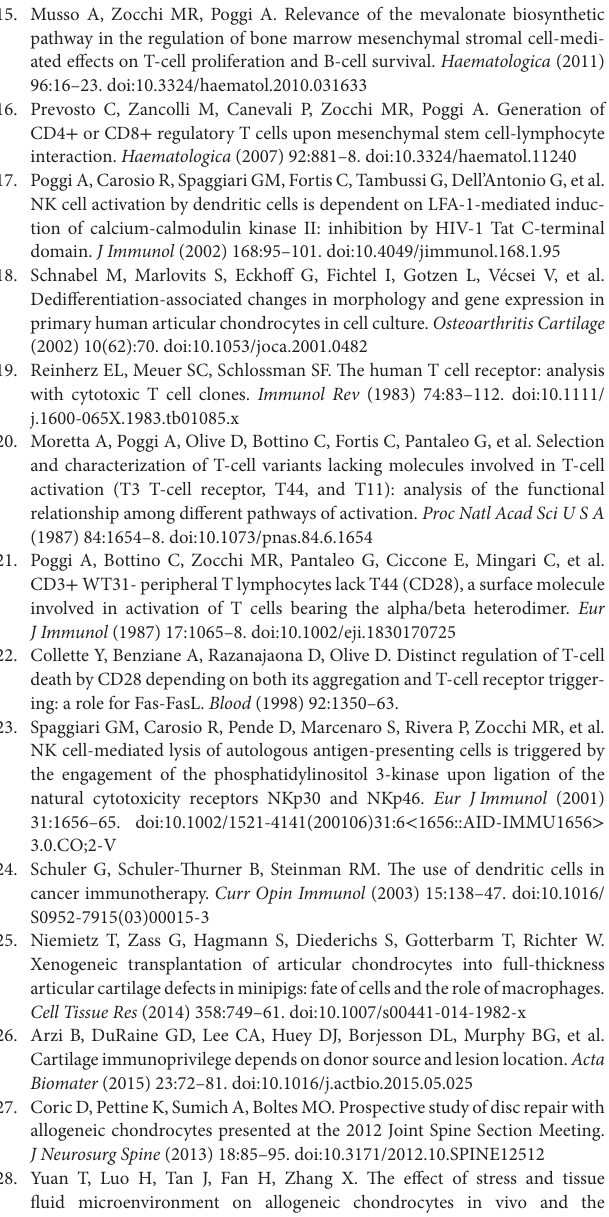
CD1a; lower left double-negative cells; lower right single CD1a + cells) on the basis of negative controls stained with an unrelated mAb matched for the isotype. Optimal compensation between the various color was performed using auto-comp included in Summit analysis program and confirmed by the staining of cells with one or another single antibody. Results are expressed as mean Log green fluorescence intensity of CD1a and the mean of fluorescence intensity of each marker indicated on y -axis in arbitrary units (a.u.). Results are 1 out of 15 independent experiments using different hAC preparations and 8 Mo donors. FigUre s5 | effect of conditioned media from Mo–hac co-cultures on Mo differentiation to iDc . Mo or hAC or Mo and hAC were cultured with GM-CSF and IL-4 for 4 days. Then, conditioned media were harvested and added (1 in 2 diluted) to Mo induced to differentiate to iDC with GM-CSF and IL-4. On day 3 (upper dot plots) and day 6 (lower dot plots), cells were harvested and stained with anti-CD1a-FITC and anti-CD14PE-Cy7 mAbs. Samples were run on a CyAN ADP cytofluorimeter and results are representative of three independent